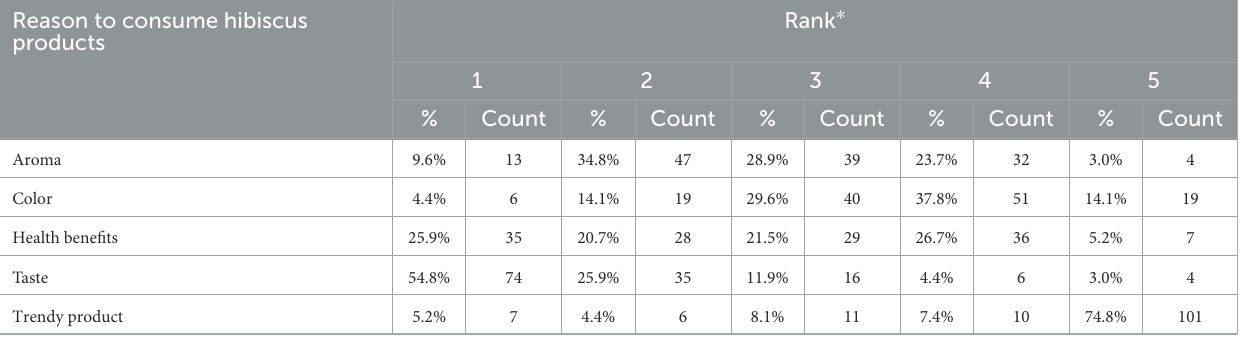
Table 5. The treatment effect lowered the mean WTP for each of the drink products, but note that the 95% confidence intervals overlap before and after the treatment for every drink